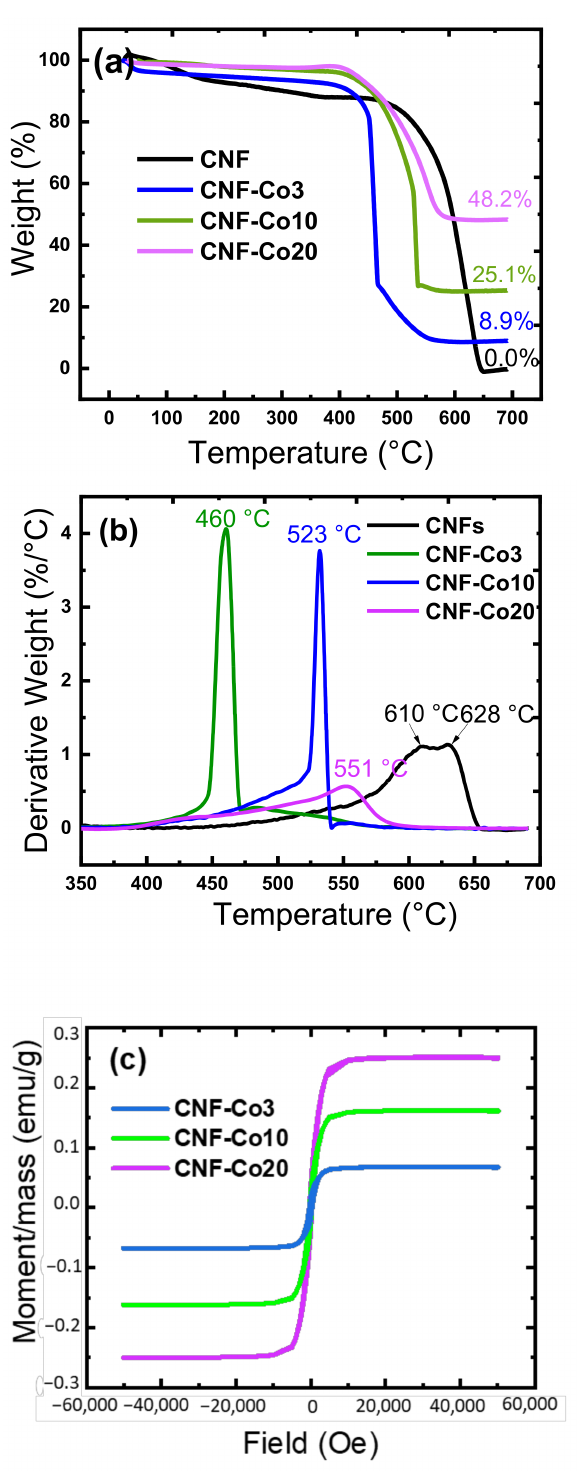
Figure 5. Features of the indicated electrodes: ( a ) TGA curves; ( b ) derivative TG curves; ( c ) VSM hysteresis curves for